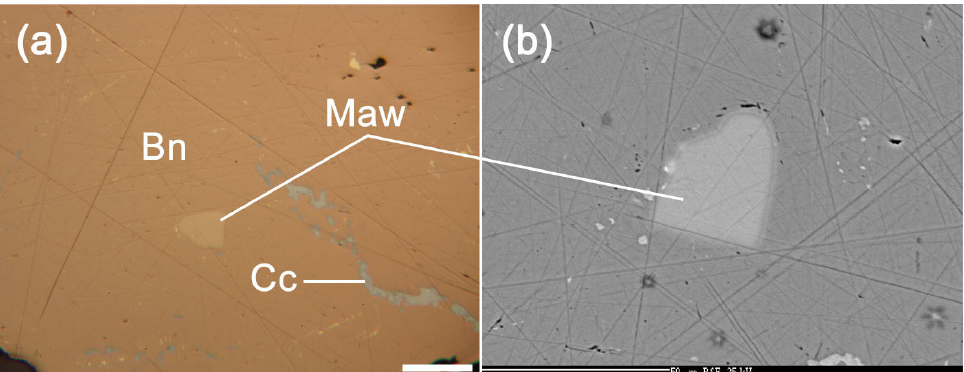
Figure 10. Plane-polarized reflected light photomicrographs ( a ) and back-scattered electron images of mawsomite (Maw) included in bornite (Bn) ( b ). Chalcocite (Cc) is also present. The scale bar on the photomicrograph is 100 μm. Table 4. Electron microprobe analysis for mawsonite (wt.%).